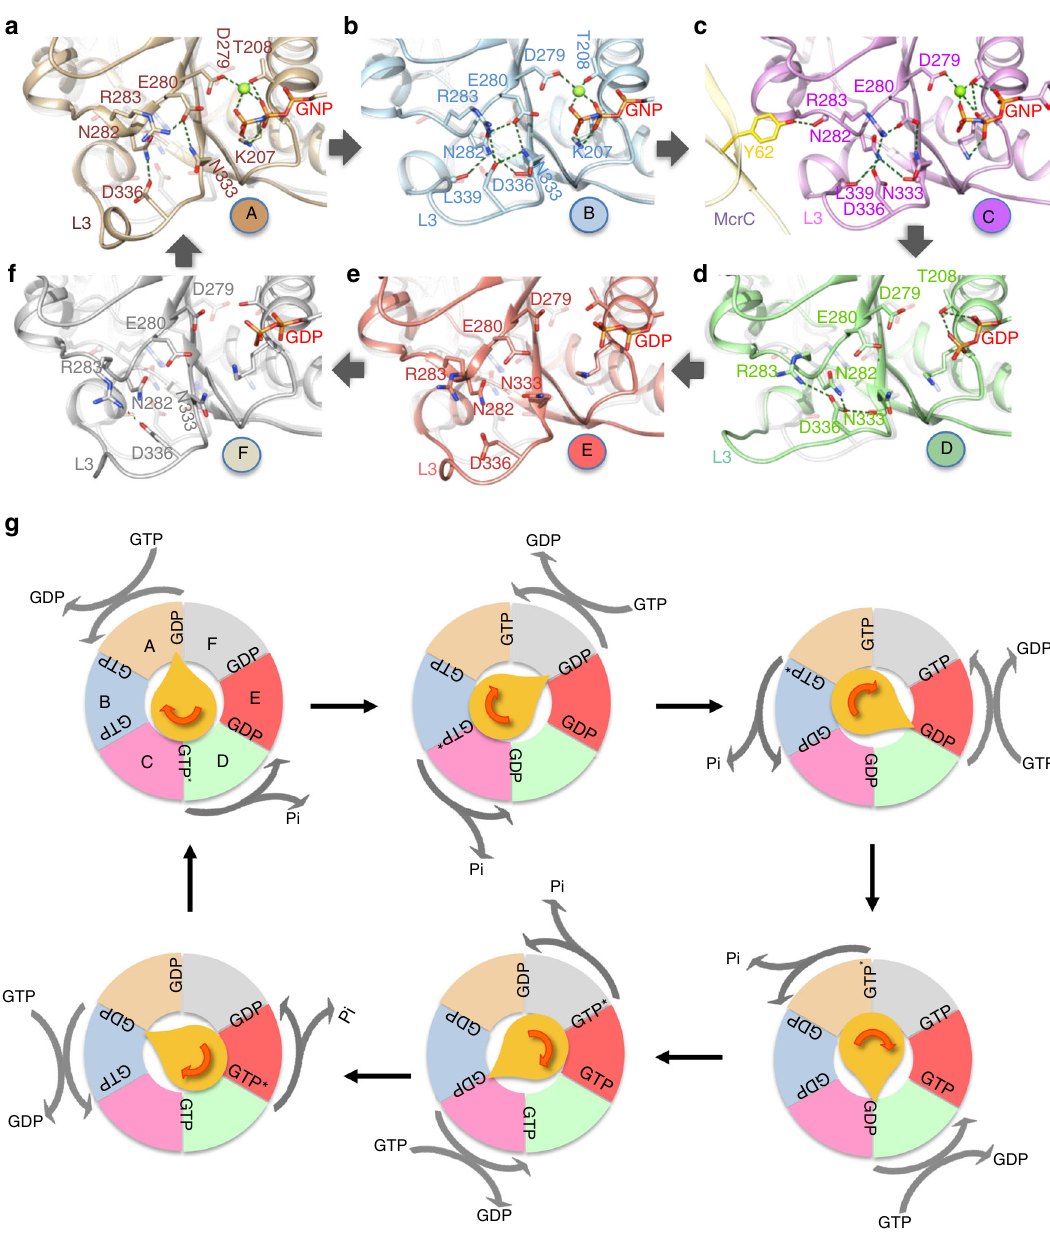
Fig. 4 Sequential GTP hydrolysis by McrBC. a – f A zoom of loop L3 of McrB Δ N protomers highlighting the conformational changes in them and the interaction network with the catalytically important McrB-Glu280 and Asn333. Overlaid on each panel is the faded image of this region in protomer C. The panels are arranged to follow the clockwise cyclic arrangement of the protomers in the hexamer. g A schematic model illustrating the McrC (yellow) stimulated GTP hydrolysis by McrB. For clarity, only one hexamer and an McrC monomer are shown, and the ring is viewed from the McrC side as in Fig. 3a. GTP* represents the transition state. The pointed end of McrC is located at the interface of GDP-to-GTP exchange and the rounded end is at the interface of GTP